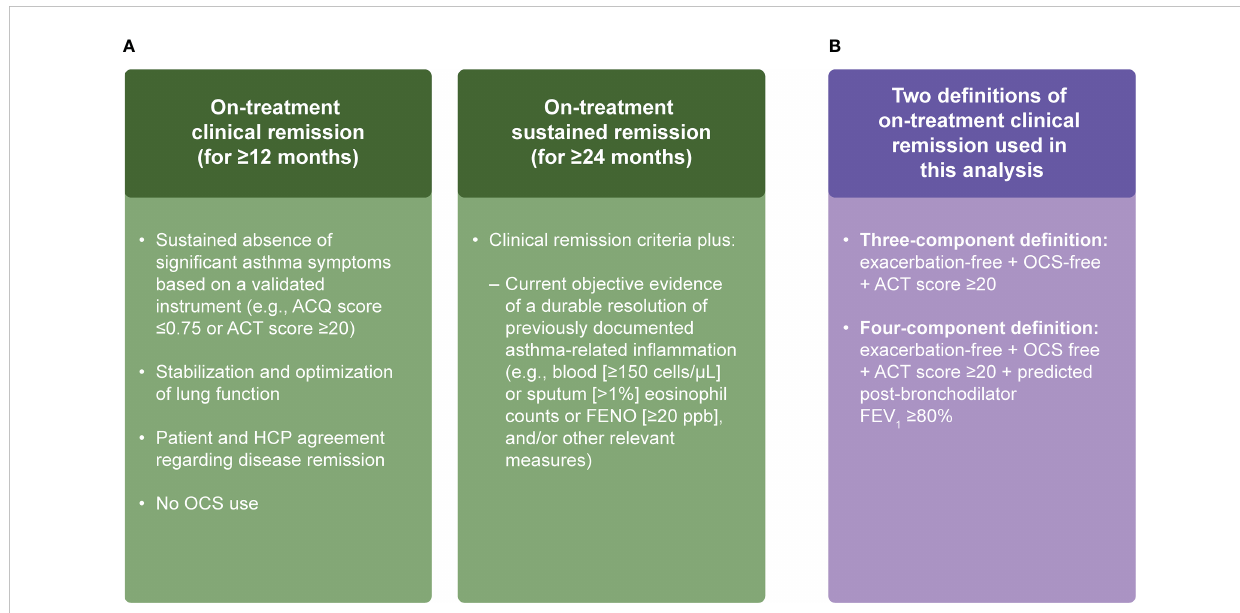
FIGURE 1 Working de fi nitions of remission in asthma (A) and our composite de fi nitions of on-treatment clinical remission for patients with severe asthma (B) (3 – 5). ACQ, Asthma Control Questionnaire; ACT, Asthma Control Test; FENO, fractional exhaled nitric oxide; FEV 1 , forced expiratory volume